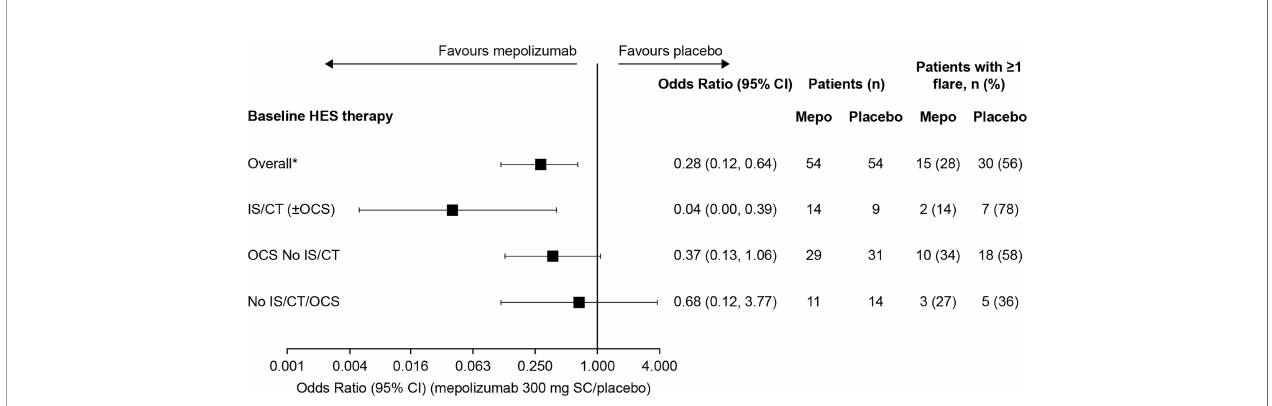
FIGURE 1 | Odds of a patient experiencing ≥ 1 fl are with mepolizumab versus placebo during the 32-week treatment period by baseline treatment type. *These values were originally reported in Roufosse et al., 2020. CI, con fi dence interval; CT, cytotoxic therapy; HES, hypereosinophilic syndrome; IS, immunosuppressive therapy; OCS, oral corticosteroid; SC, subcutaneous.